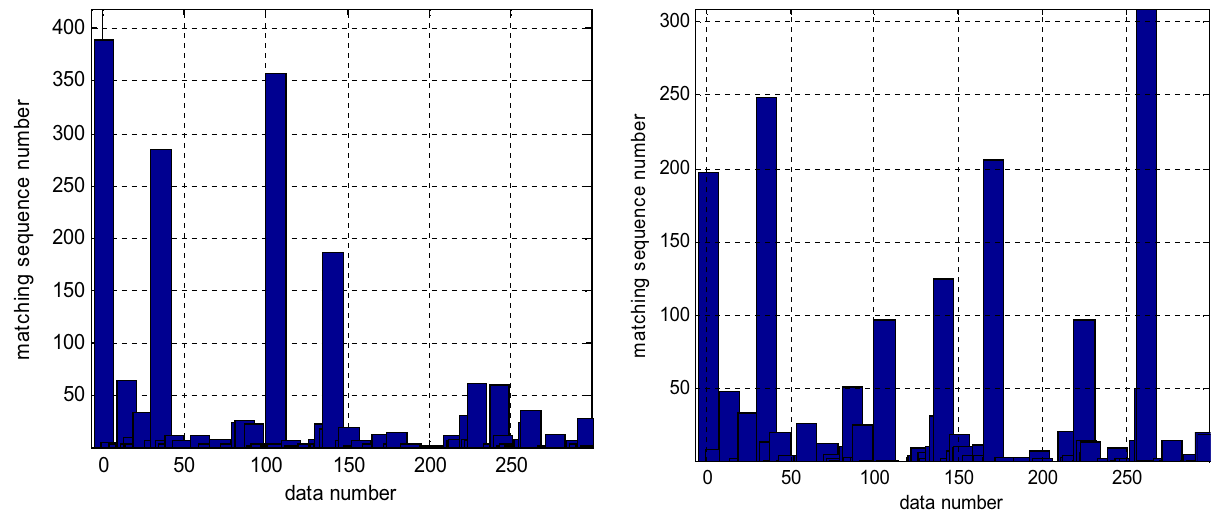
Figure 7: Identi fi cation results of matching sequence number fre - quency statistics based on fuzzy closeness.